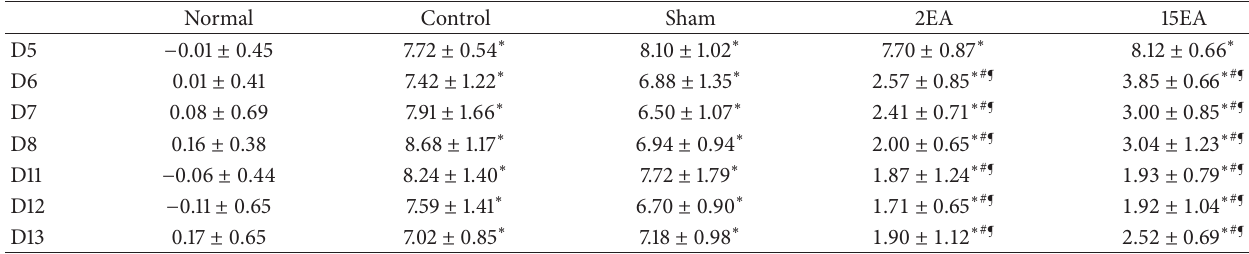
Table 1: Effect of electroacupuncture (EA) on radiant heat test on SD rat with chronic constriction injury (CCI)-induced neuropathic pain